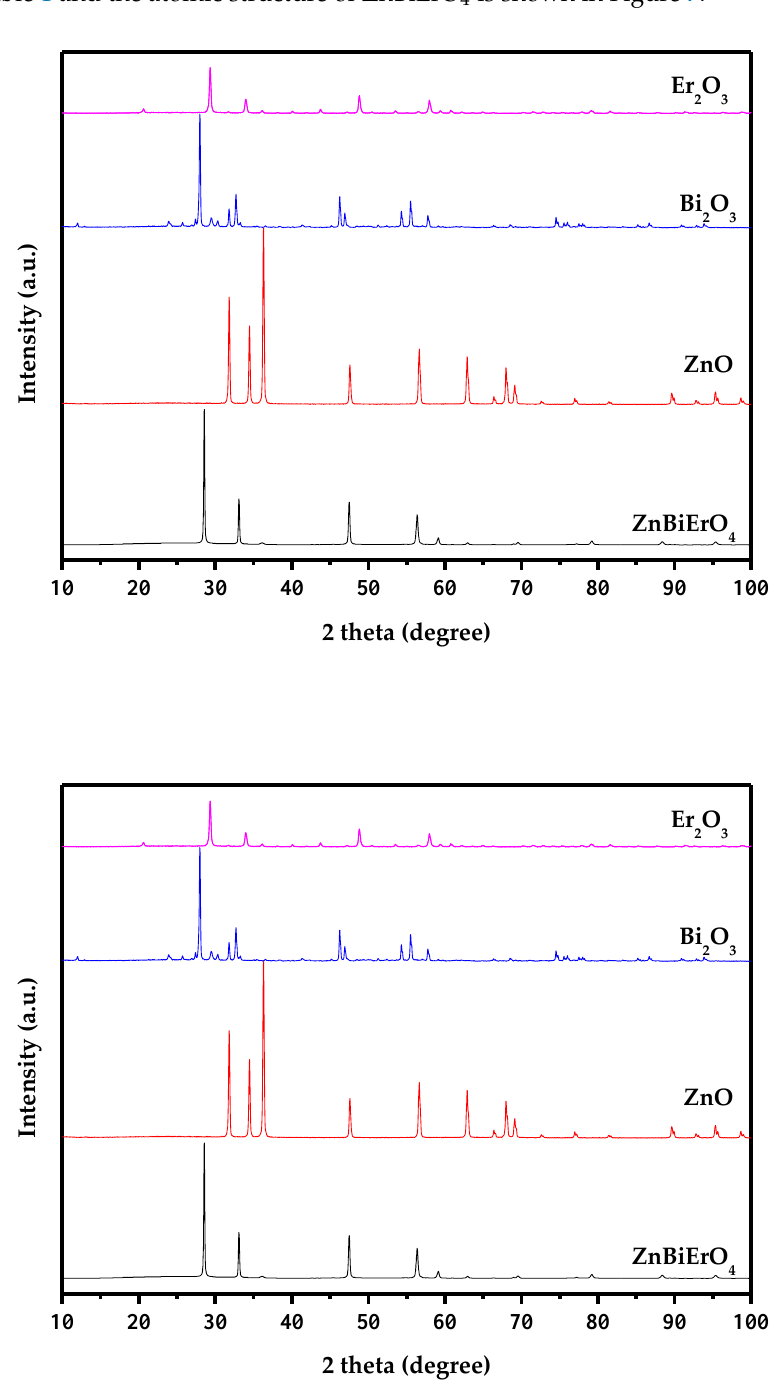
Figure 5. X-ray powder diffraction patterns of ZnBiErO 4 , ZnO, Bi 2 O 3 and Er 2 O 3 .